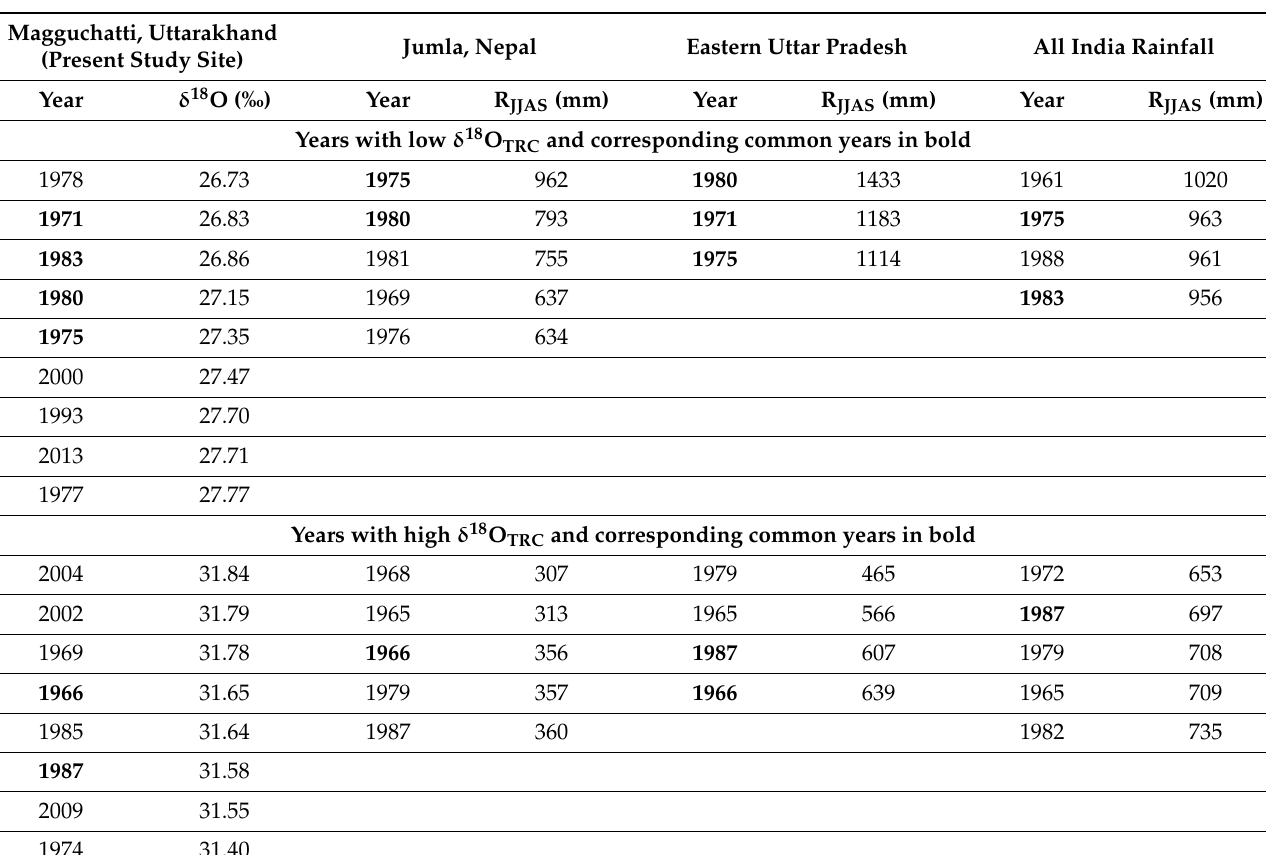
Table 2. Years with low and high δ 18 O TRC values from our study site compared with the summer monsoon (June–September) rainfall record for Jumla (Nepal), eastern Uttar Pradesh, and all-India rainfall after Sano et al. 2010. R = JJAS rainfall (mm). The common years are in